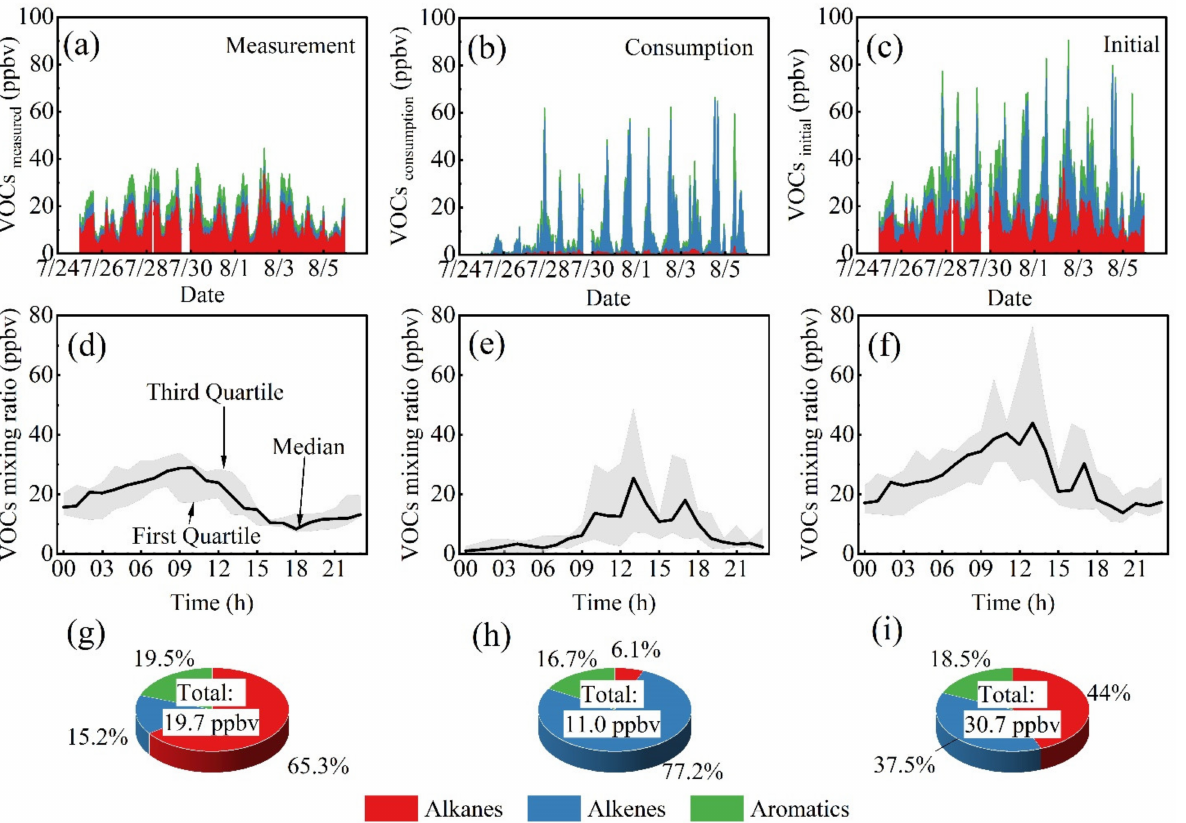
Figure 4. Time series ( a – c ), diurnal variation ( d – f ), and proportion ( g – i ) of VOCs measurement, consumption, and photochemical initial concentrations during the observation period. The gray areas in panels ( d – f ) represent the VOCs’ mixing ratio between 25% and 75%